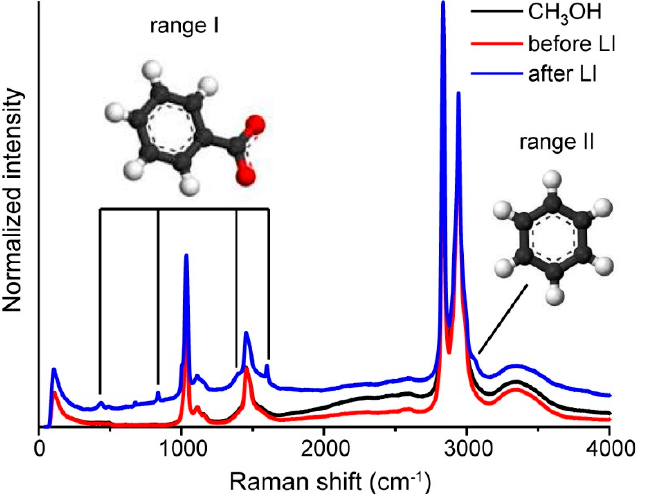
Figure 5. Raman spectra of methanol (black), silver benzoate solution in methanol before exposition under laser irradiation (red), and after exposition under laser irradiation (blue).